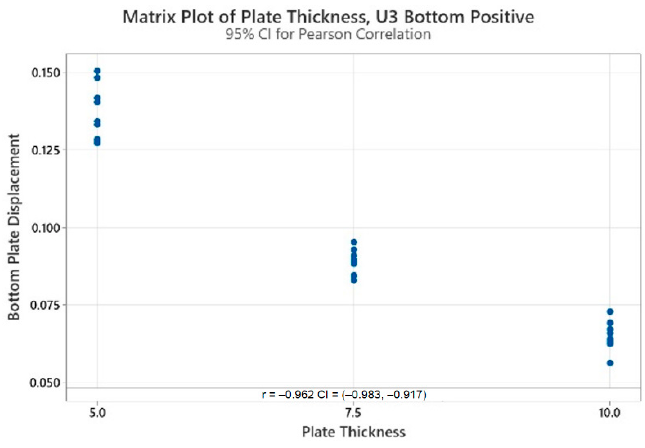
Figure 18. Plate thickness and the bottom plate displacement correlation.